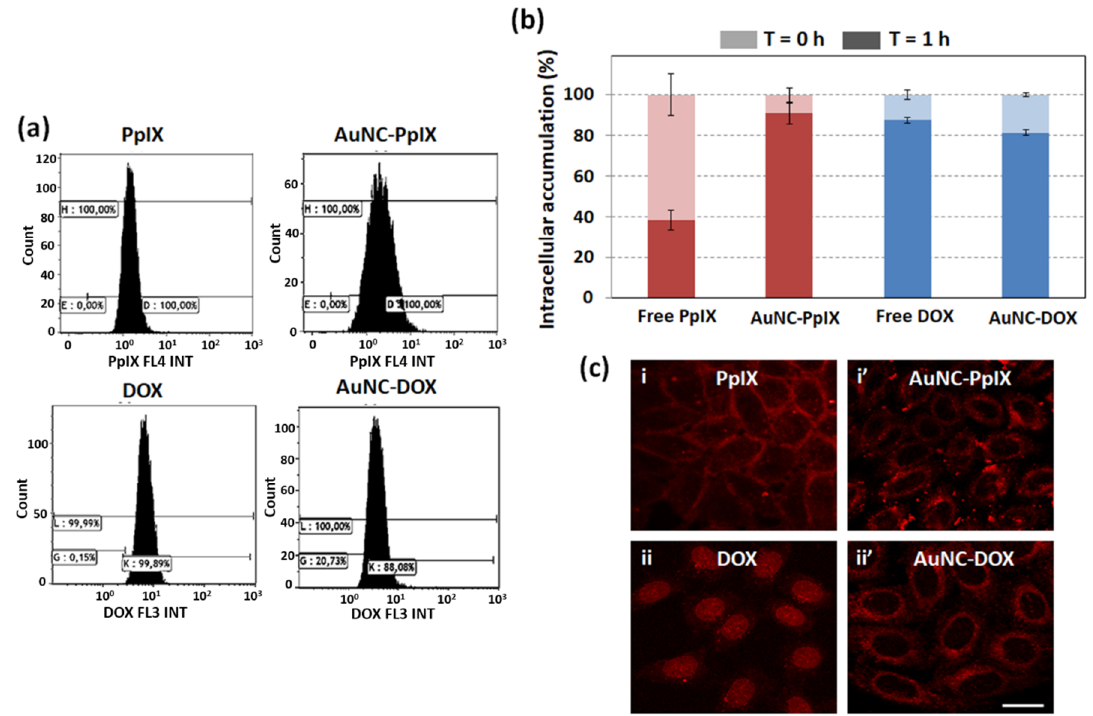
Figure 5. Attachment to AuNCs increases PpIX accumulation inside HeLa cells. ( a ) Analysis of free and AuNCs-attached PpIX and DOX accumulation by flow cytometry; ( b ) Relative accumulation of compounds inside HeLa cells just after washing and 1 h later; ( c ) Subcellular localization of free and AuNCs- attached PpIX and DOX. Scale bar: 20 μm.